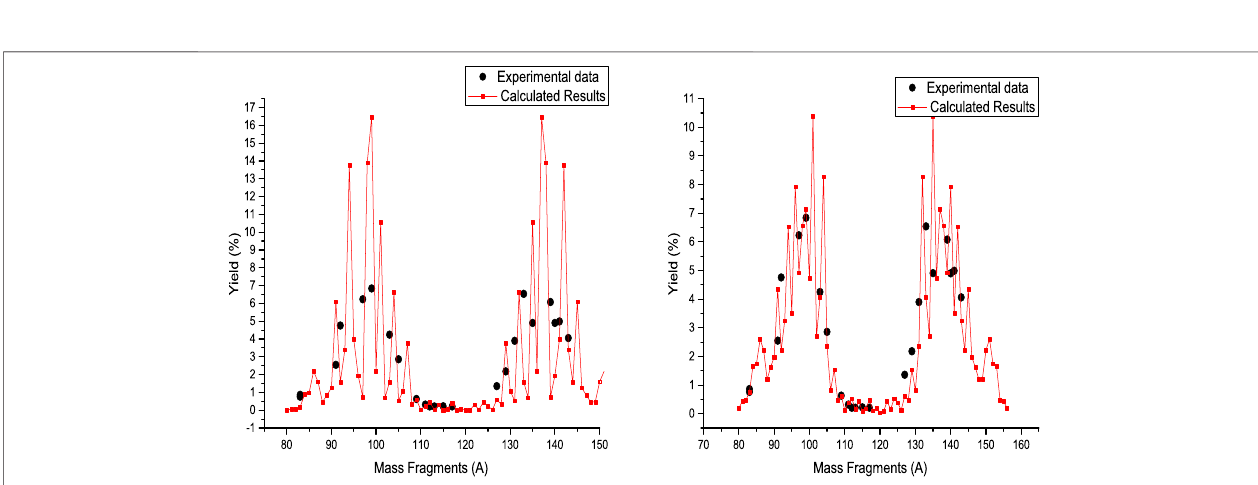
FIGURE 5 | Calculated mass yield for photo fi ssion of 239 Pu at 28 MeV bremsstrahlung endpoint energy, accompanied by experimental data [40]. In the left and right sides are presented the calculated results obtained for T coll (cid:1) 1 MeV and T coll (cid:1) 2 MeV, respectively.